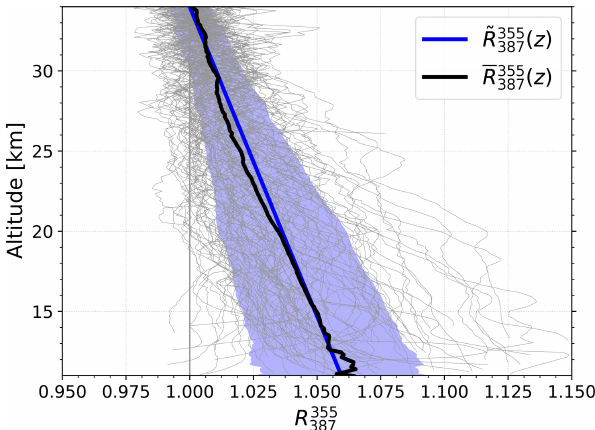
Figure 6. Backscatter ratio, color ratio and approximate backscat- from nighttime measurements in ter ratio profiles ( R 1064 , R 532 ) for a 97h measurement starting 387 355 355 07:45UT on 10 October 2015 (the same measurement as in Fig. 4). 355 Colored shaded areas around the lines indicate the measurement un- 387 (z) is certainty. Further explanations are given in Fig. (z) is a linear fit to R 355 387 (z) . The 387 profiles. 387